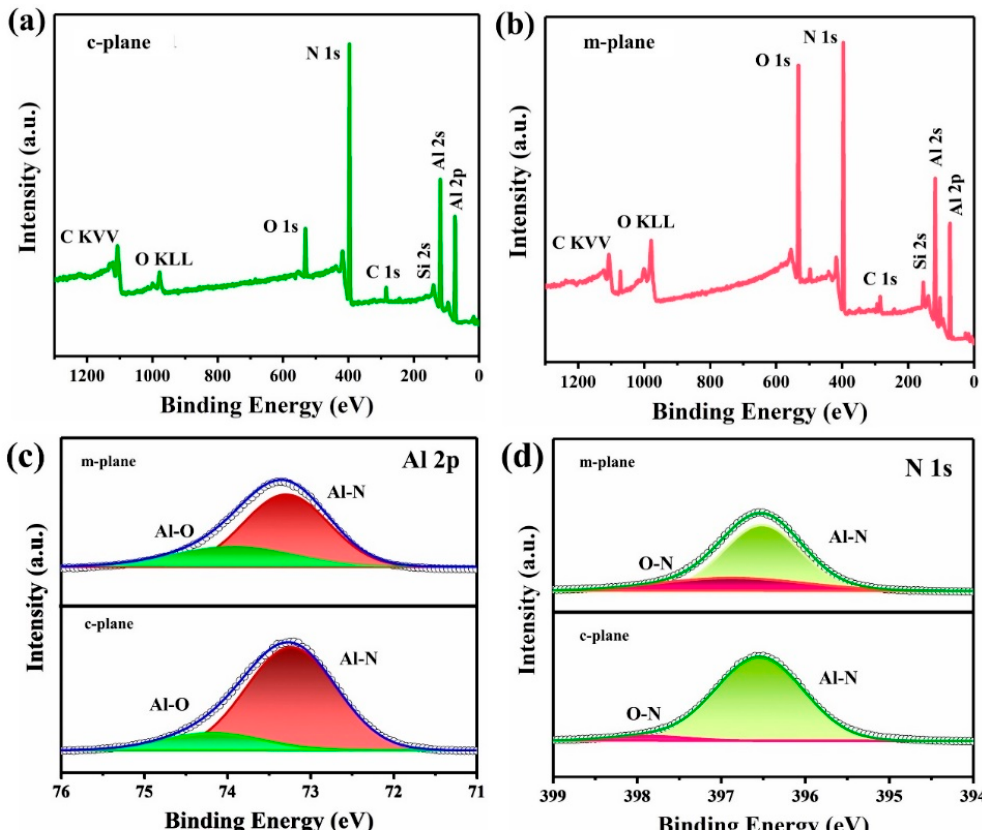
Figure 4. XPS survey of the c-plane ( a ) and m-plane ( b ), and Al 2p ( c ) and N 1s ( d ) high-resolution XPS spectra of the c-plane and m-plane.